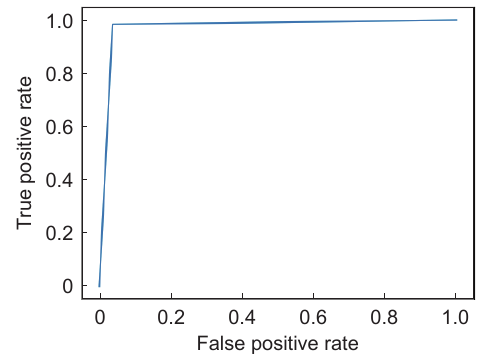
Fig. 4 ROC curve and AUC index of LR.